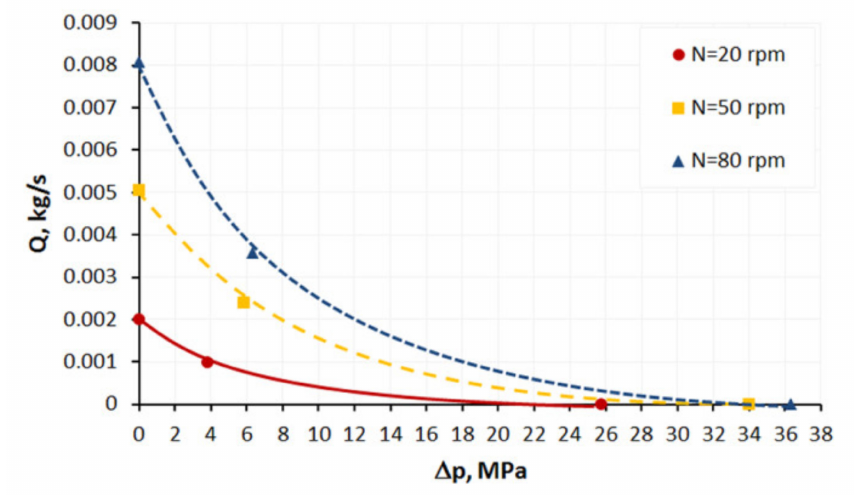
Figure 8. Screw characteristics at varoius screw speed ( F slip = 0.064, e slip =